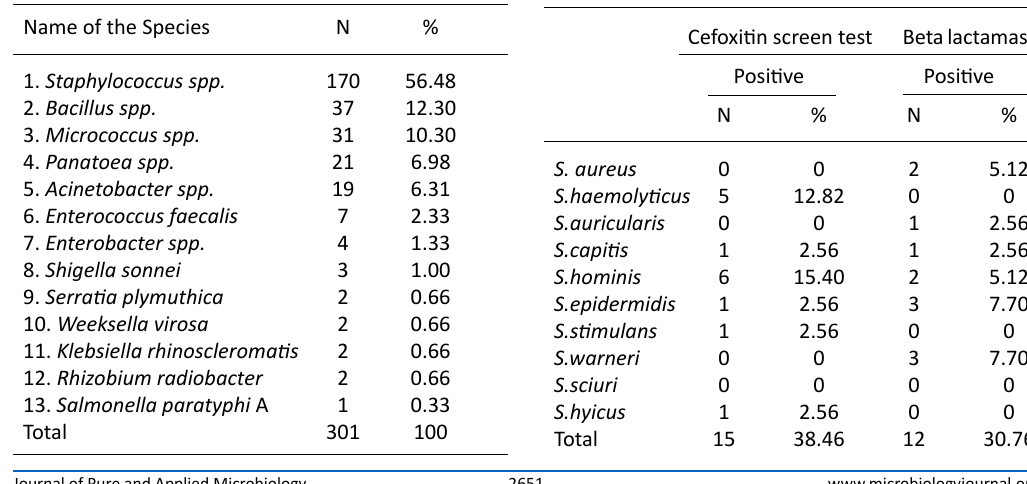
Fig. 1. City distribution of bacterial contamination in Qassim table 2. Cefoxitin test and beta lactamases for Staphylococcus spp. (N=39)